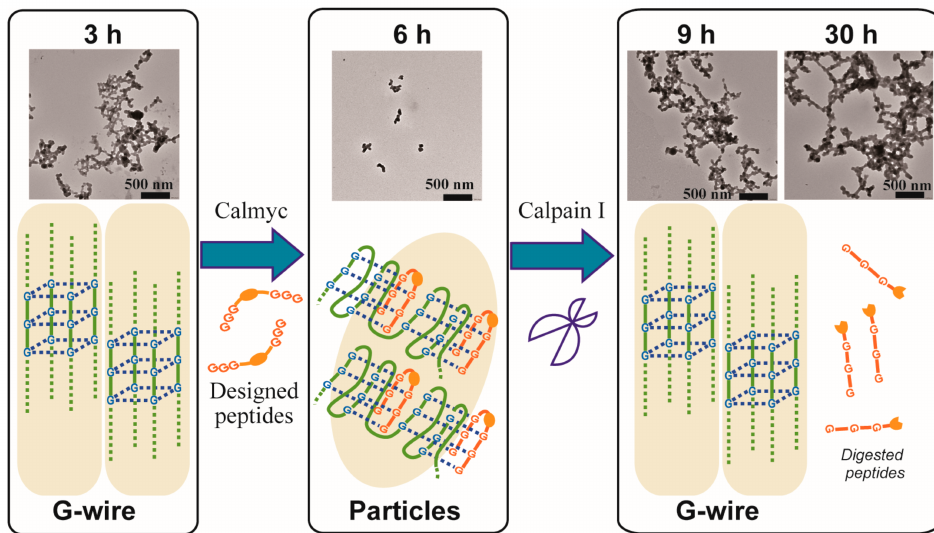
Figure 9. TEM images of reversible switching of DNA nanowire formation with time using the peptide and the protease. MYC alone in the presence of Ca 2+ was incubated for 3 h (the 3 h TEM image in the left column), the peptide was then added, and the sample was incubated for another 3 h (the 6 h TEM image in the middle column). After a total of 6 h of incubation, calpain I was added, and the sample was incubated for another 3 h or 24 h (the 9 h TEM image and the 30 h TEM image in the right